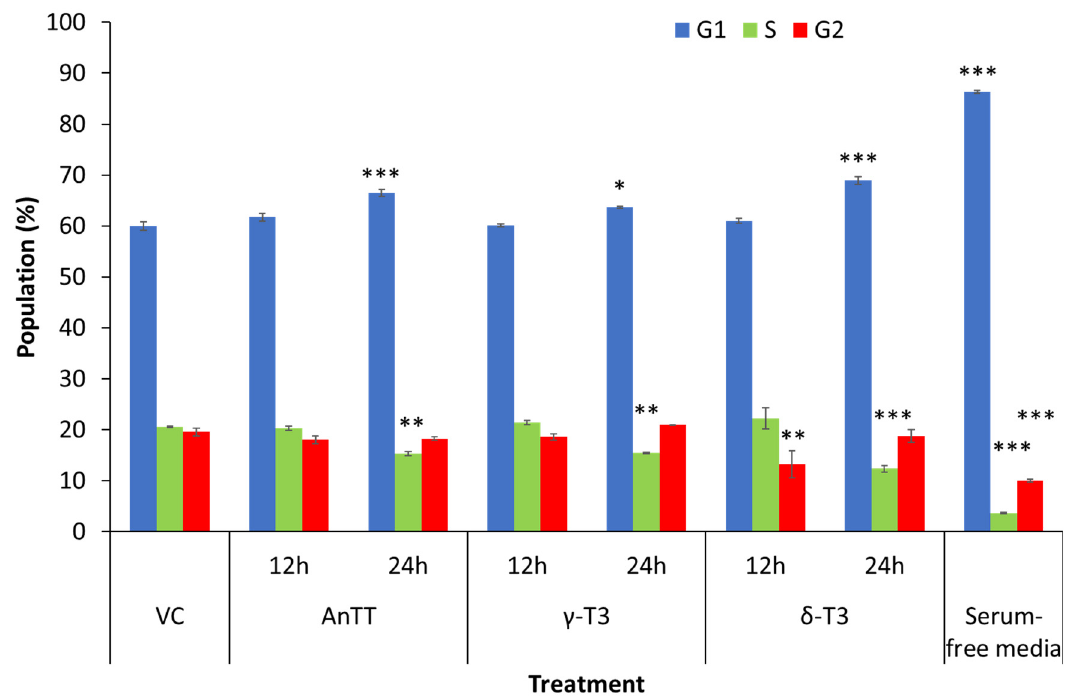
Figure 5. The quantitative analysis of cell cycle distribution after tocotrienol treatment for 12 and 24 h. AnTT, γ -T3 and δ -T3 in their IC 50 concentration induced G1 arrest on SW1353 chondrocytes upon 24 h treatment with the lower S or G2-phase percentage. The shorter treatment time of 12 h did not significantly alter the cell cycle distribution. A 24 h serum-free condition was performed to arrest the SW1353 cells at the G1 phase. *, ** and *** indicate significant differences of p < 0.05, p < 0.01 and p < 0.001 compared to VC. Abbreviations: AnTT, annatto tocotrienol; δ -T3, δ -tocotrienol; γ -T3, γ - tocotrienol; VC, vehicle control.